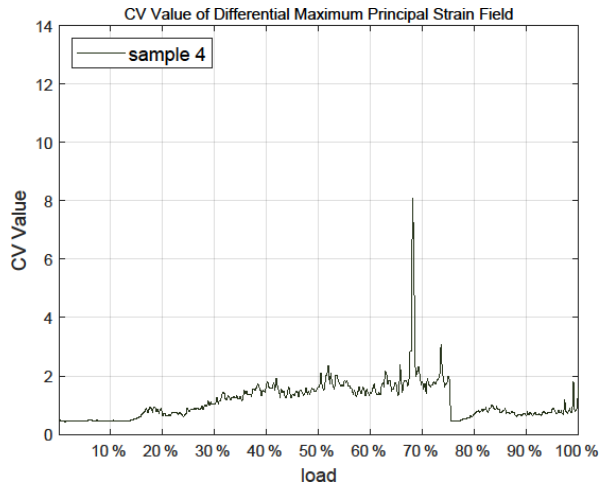
Figure 3. CV of differential maximum principal strain for sample 4.